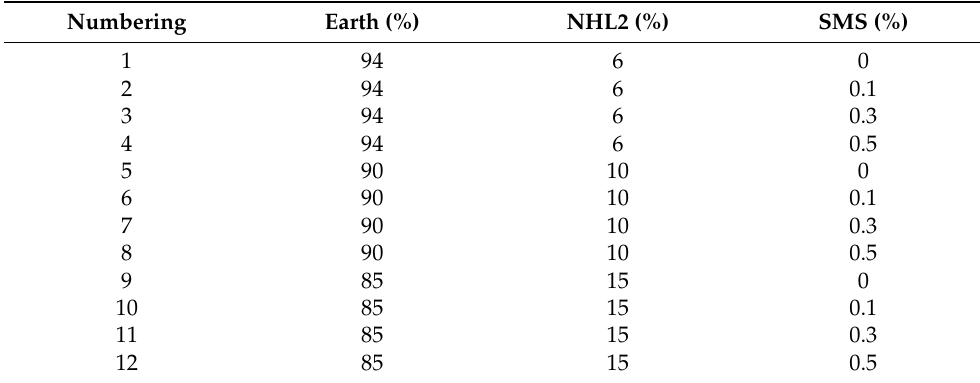
Table 3. Test ratio